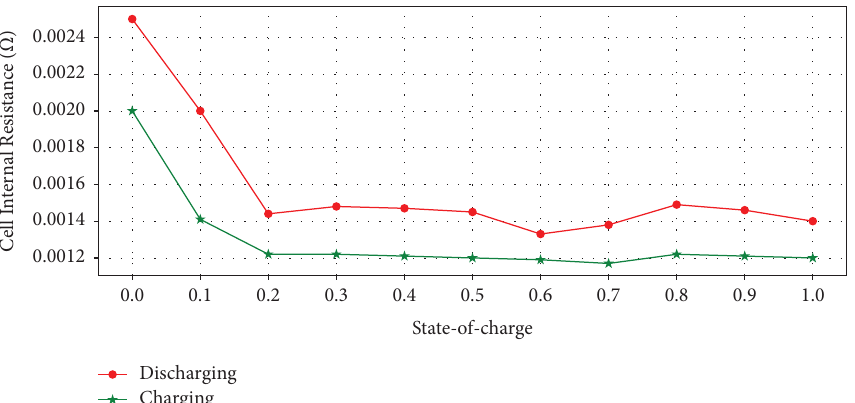
Figure 1: Cell internal resistance values at diferent SOC.